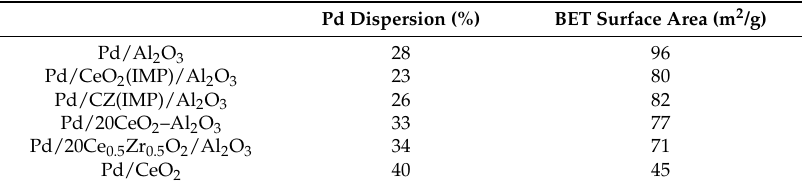
Table 1. Metal Dispersion and BET Surface Area of Catalysts.